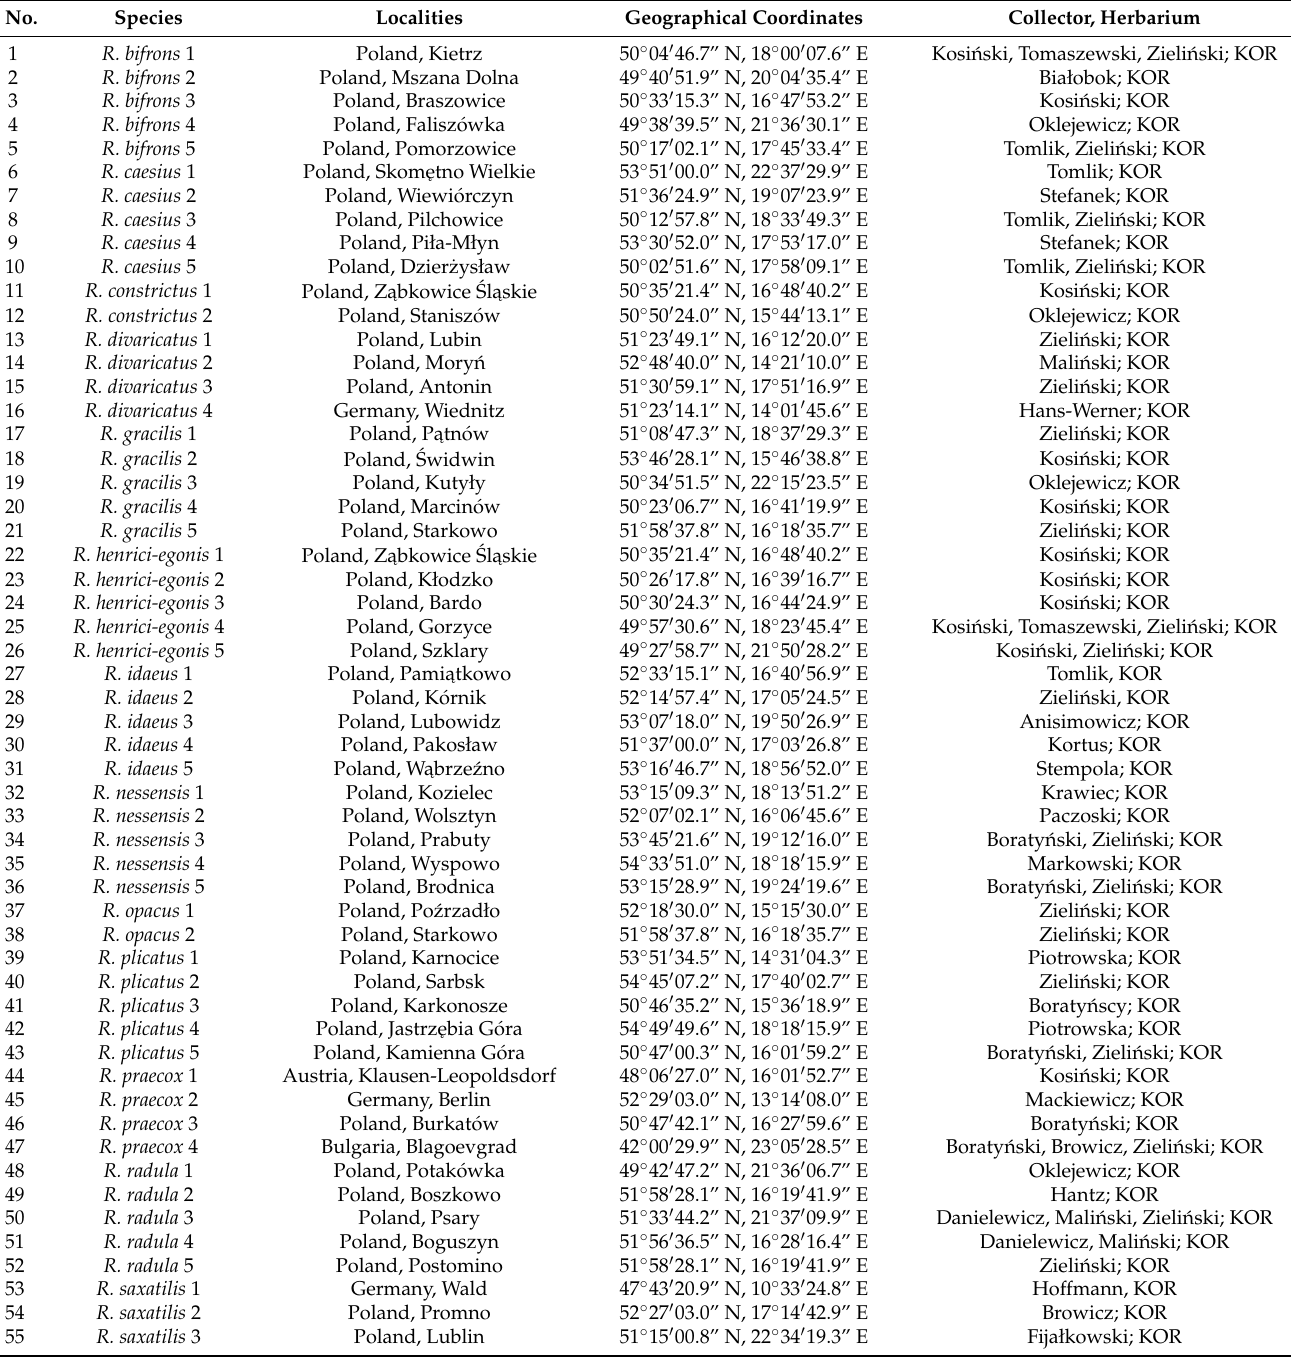
Table 2. List of proveniences of the Rubus species samples